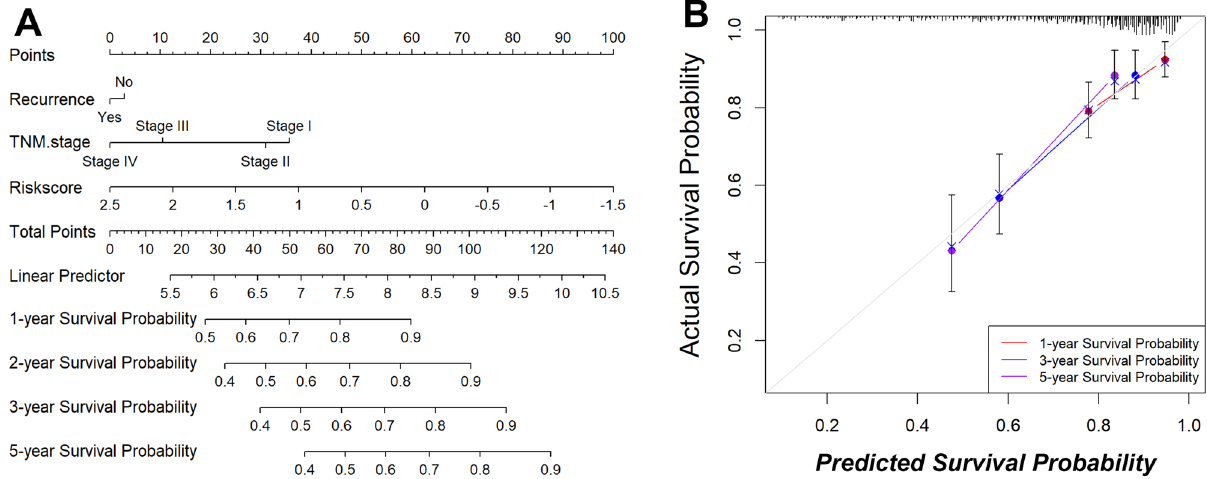
Figure 9. The predictive significance of the Cuproptosis-associated lncRNA signature was verified in the nomogram model. ( A ) Nomogram combining the six Cuproptosis-associated lncRNA signatures. ( B ) Calibration plots of 1-, 2-, and 3-year survival probabilities.